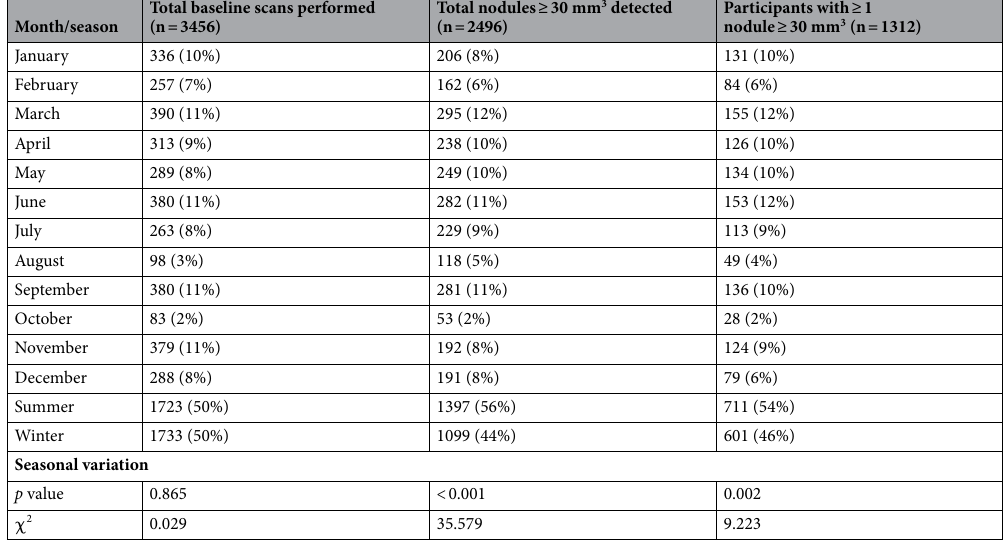
Table 2. Distribution of baseline scans, total nodules detected and participants with ≥ 1 lung nodule > 30 mm 3 (~ 3 mm in diameter).